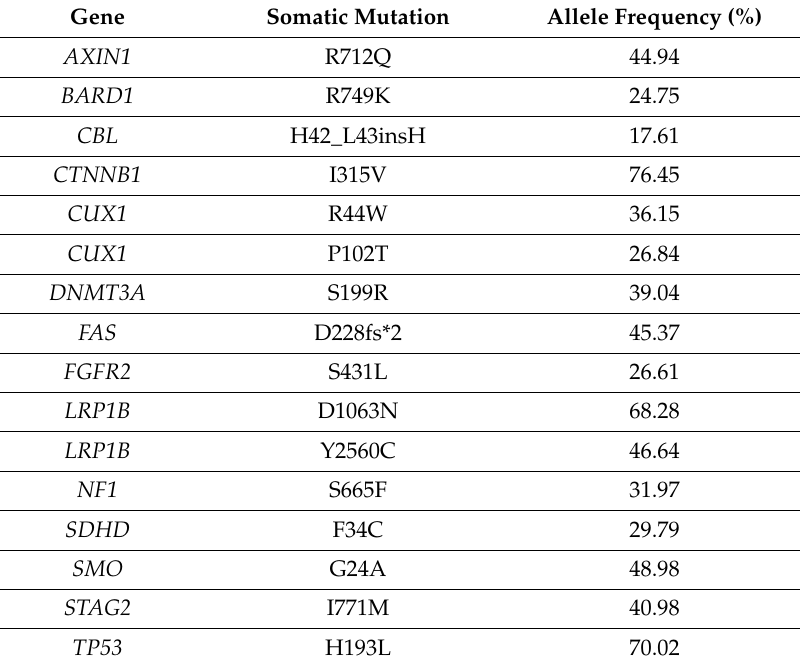
Table 1. Somatic mutations identified by next-generation sequencing (NGS).